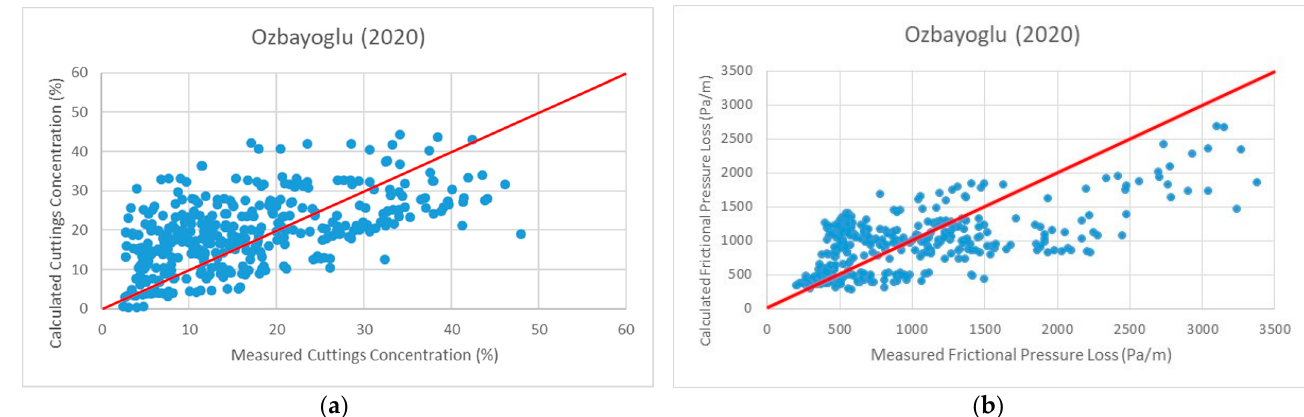
Figure 2. Comparison of calculated versus measured values using Ozbayoglu’s model [48]: ( a ) total cuttings concentration and ( b ) frictional pressure loss.